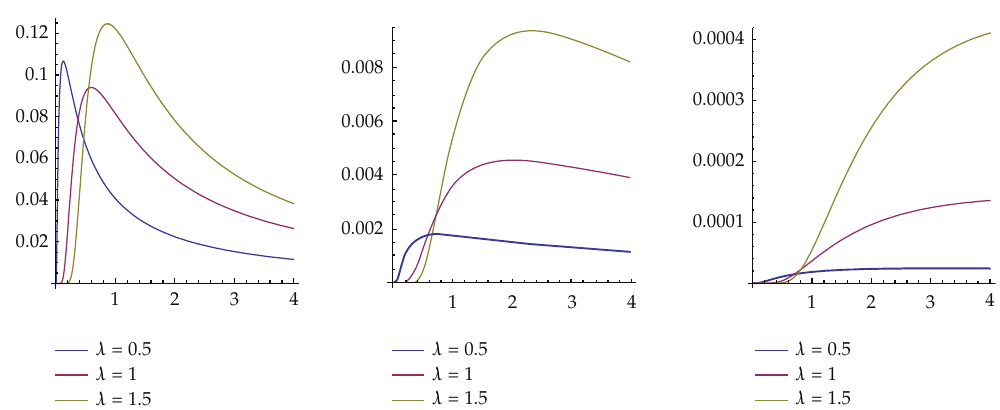
Figure 1: Graph of p.d.f. of (cid:2) inid (cid:3) o.s. from Ef distribution for selected values of α 1 (cid:6) 0 . 03; α 2 (cid:6) 0 . 05;